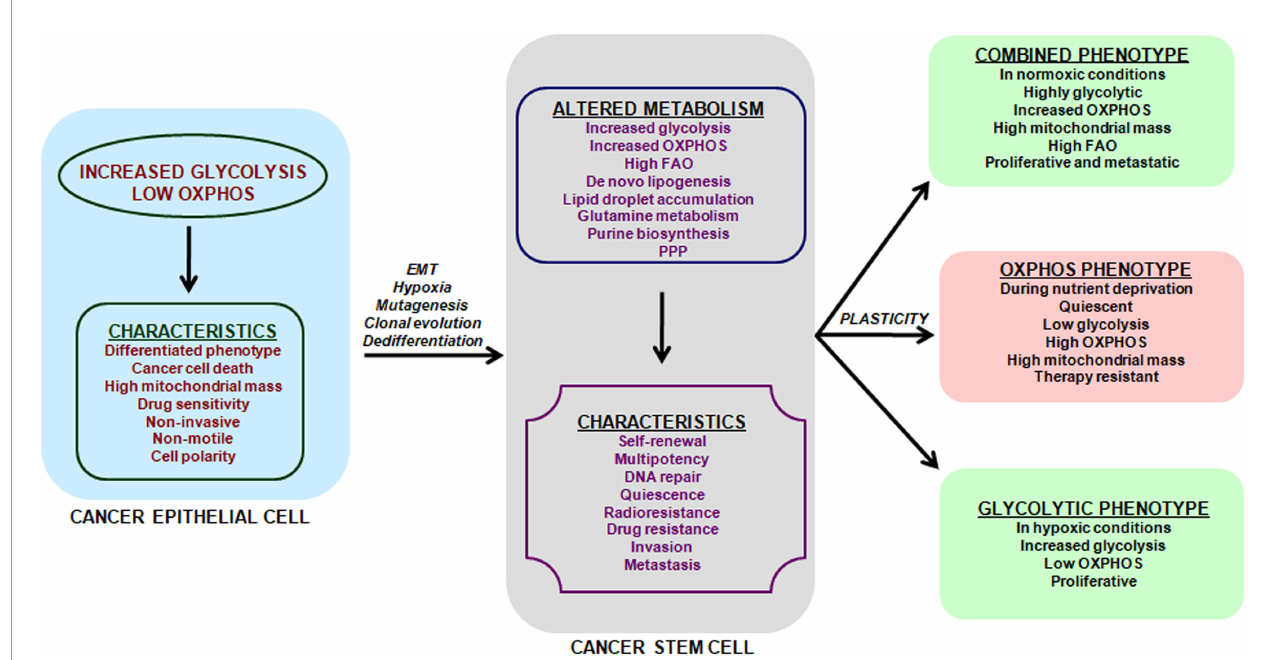
FIGURE 1 | Metabolic features and plasticity of CSCs. Cancer is a heterogeneous disease with multiple sub-populations of cells and CSCs form the self-renewing and tumorigenic core in a tumor. Cancer cells have a predominant glycolytic phenotype and use aerobic glycolysis for tumor growth. This altered metabolism in cancer cells may trigger EMT, hypoxia, cell de-differentiation, mutagenesis and clonal evolution for acquisition of CSCs phenotype. The metabolic alterations in CSCs promote cell-renewal, immune system escape and invasive and metastatic potential. CSCs unlike cancer cells can use glycolysis, OXPHOS or both, depending on their oncogenic background and bio-energetic needs. This freedom of metabolic choice makes CSCs metabolically plastic and they easily shuf fl e between metabolic phenotypes, based on their state i.e. proliferative or quiescent. EMT, epithelial to mesenchymal transition; FAO, fatty acid oxidation; PPP, Pentose phosphate